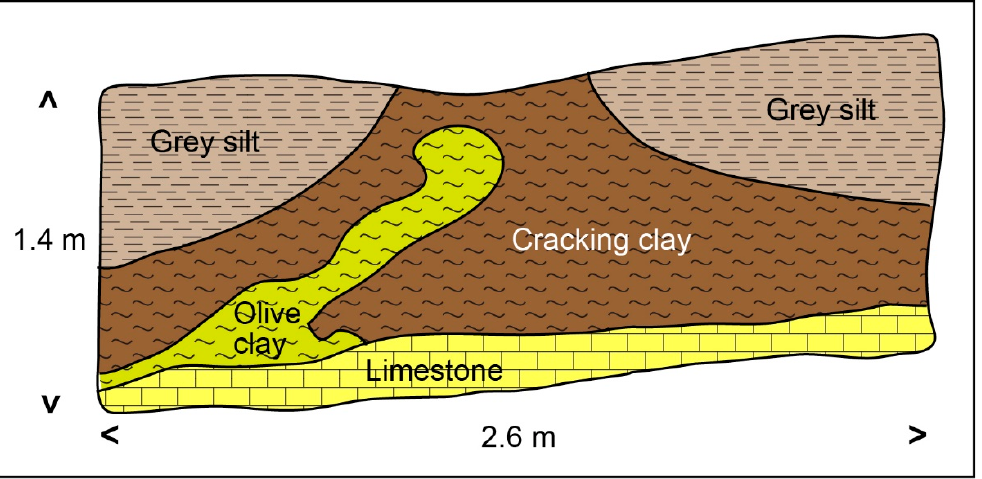
Figure 12. Diapiric structure in a clay soil at a prehistoric archaeological site in central New South Wales, Australia. Based on the author’s